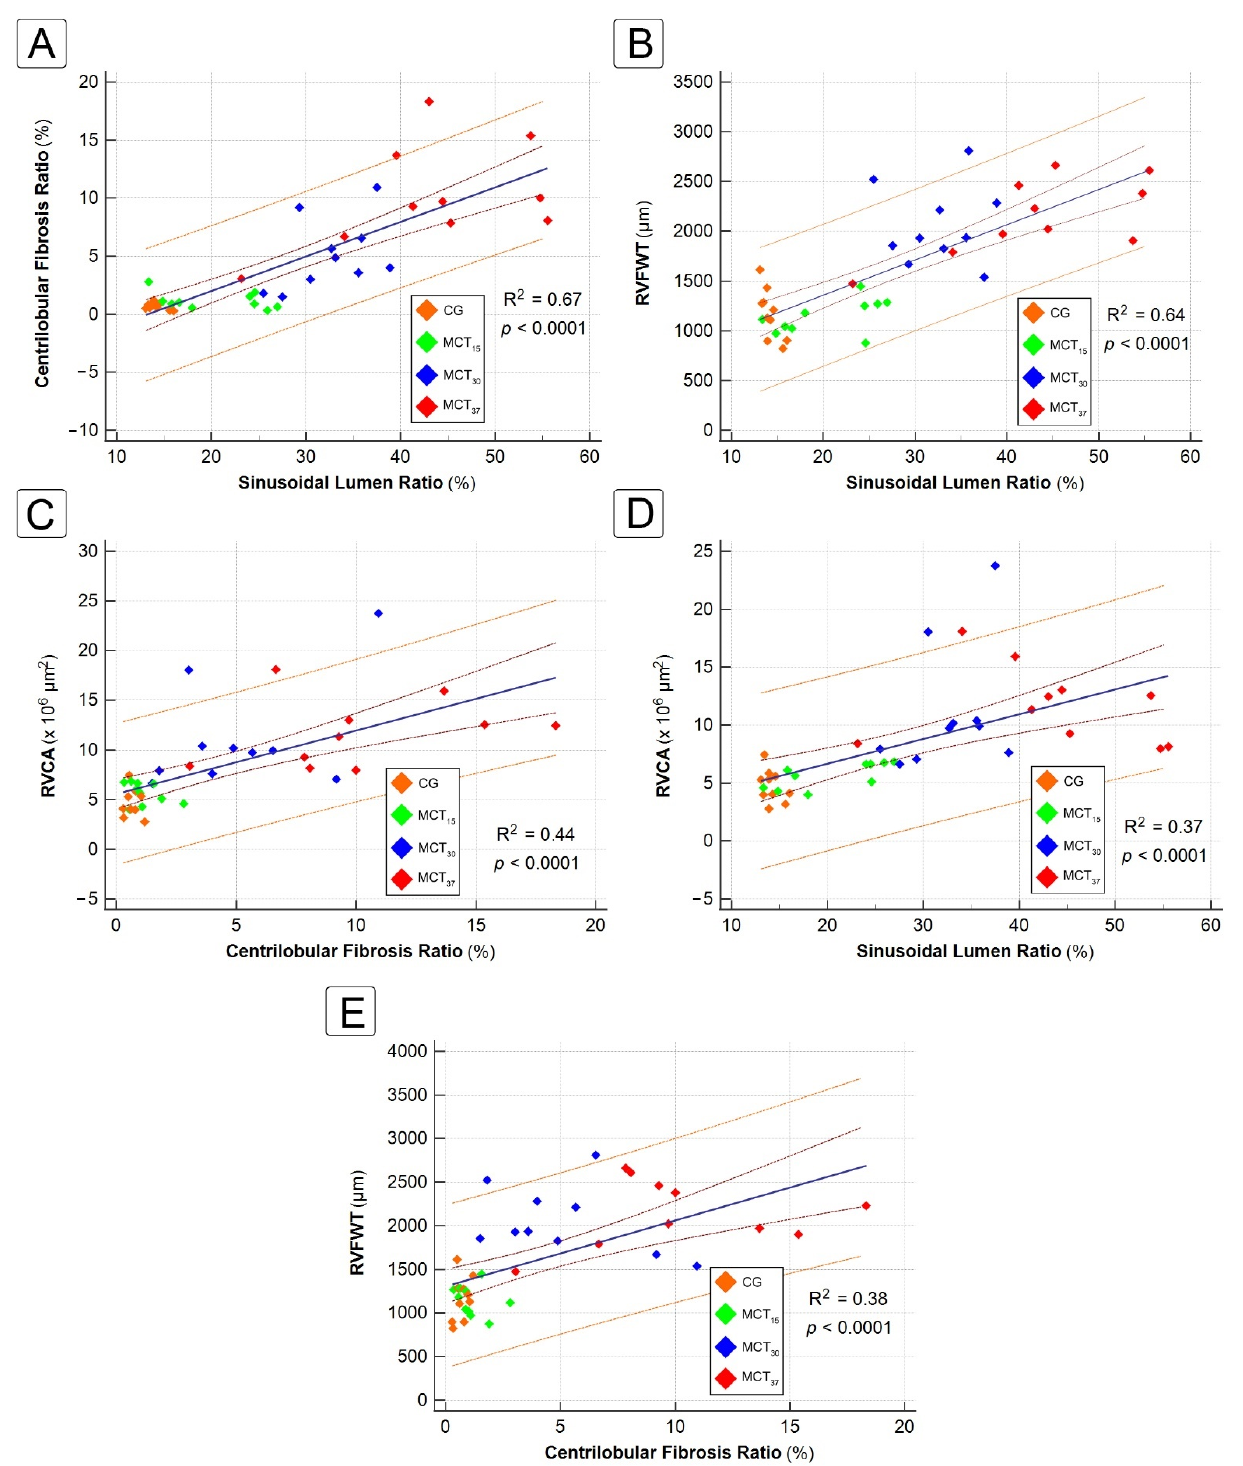
Figure 6. Linear regression analysis of the relationships between centrilobular fibrosis ratio, sinusoidal lumen ratio and cardiac morphometric parameters. ( A ) Correlation between centrilobular fibrosis ratio and sinusoidal lumen ratio. ( B ) Correlation between sinusoidal lumen ratio and RVFWT. ( C ) Correlation between centrilobular fibrosis ratio and RVCA. ( D ) Correlation between sinusoidal lumen ratio and RVCA. ( E ) Correlation between centrilobular fibrosis ratio and RVFWT. RVFWT, right ventricle free wall thickness; RVCA, right ventricle chamber area.